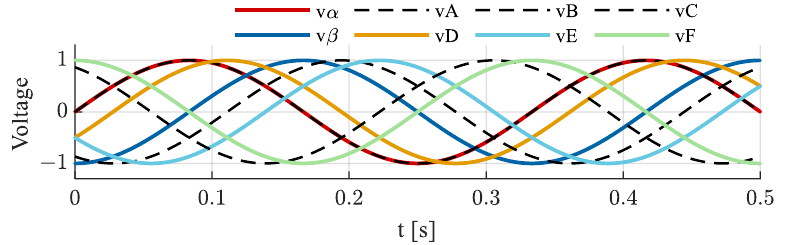
Figure 3. Simulation of the transformation between phase coordinates D – E – F to the stationary α–β subspace at the zero-position reference frame.